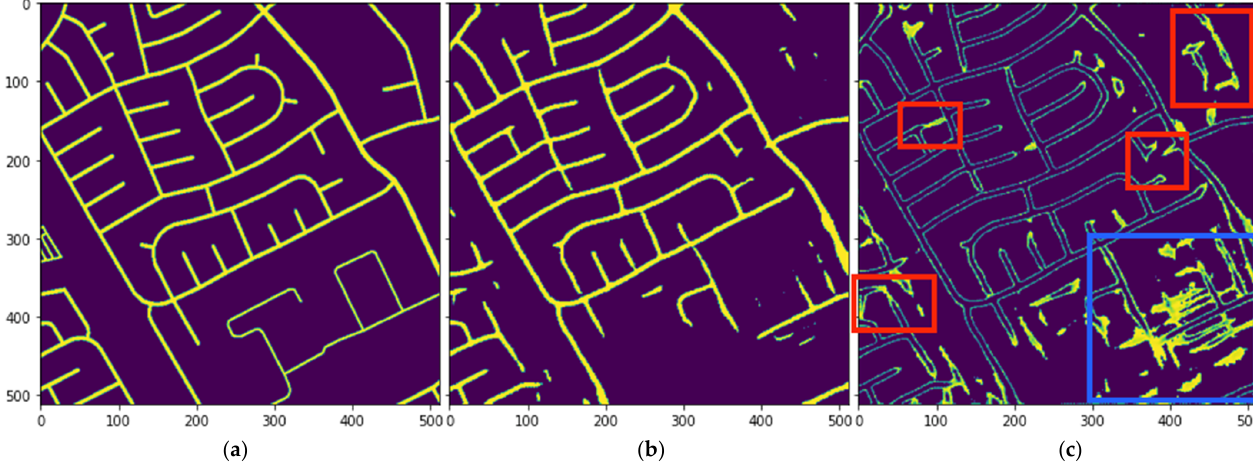
Figure 6. Ground truth ( a ), softmax predictions ( b ) (higher is brighter) and softmax predictions ( c ) in [0.01,0.5] (lower is brighter). Non-road predictions tend to be very confident (i.e., near zero; dark regions). Uncertainty tends to increase in connective regions (as denoted by red and blue squares). However, as the region inside the blue square indicates, this is not simply a matter of calibration. Selecting these pixels for uncertainty measurement would appropriately increase uncertainty; however, lowering the threshold for road prediction measurement in this region would result in a very high false positive rate.